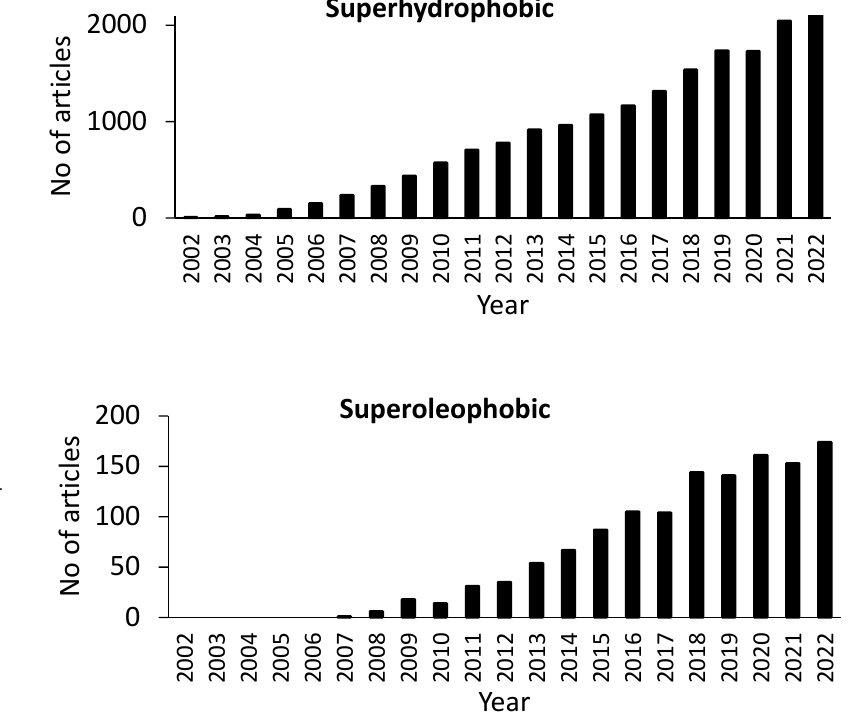
Figure 1. Number (No.) of published articles per year which include the words “superhydrophobic” and “superoleophobic” in their titles, abstracts or keywords. Data were obtained from Scopus (February 2023).